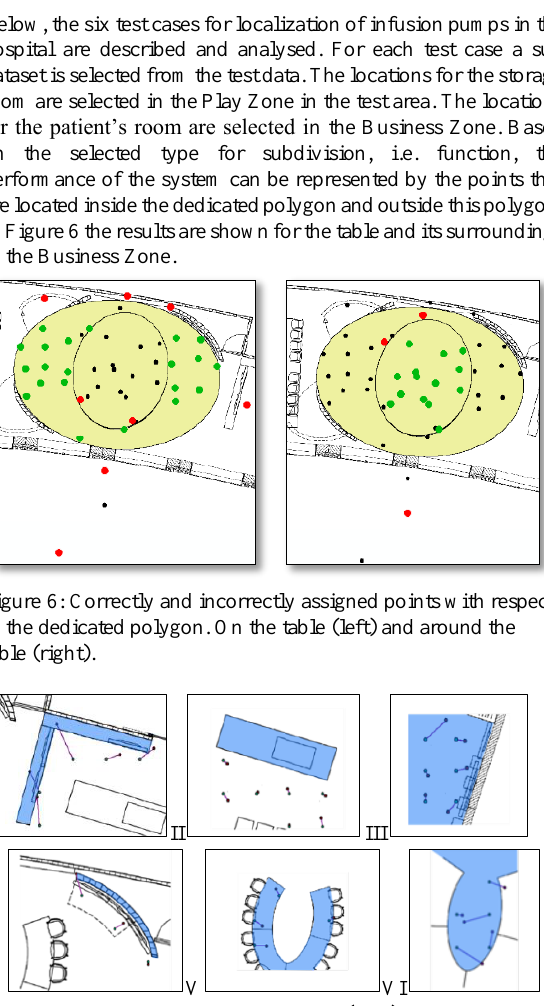
Figure 7: Test cases along the cupboard (I,IV), situated on a table (II,V) and the test cases for the walking area